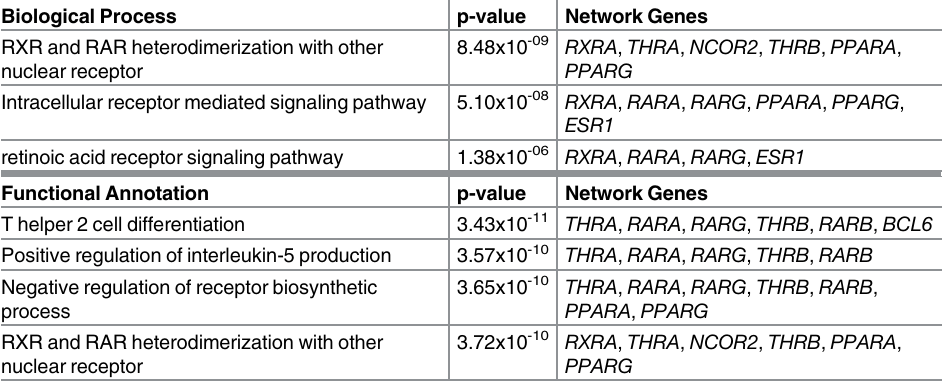
Table 1. Enriched pathways in the IMP posterior network (Fig 4) with data-driven epistasis network seed